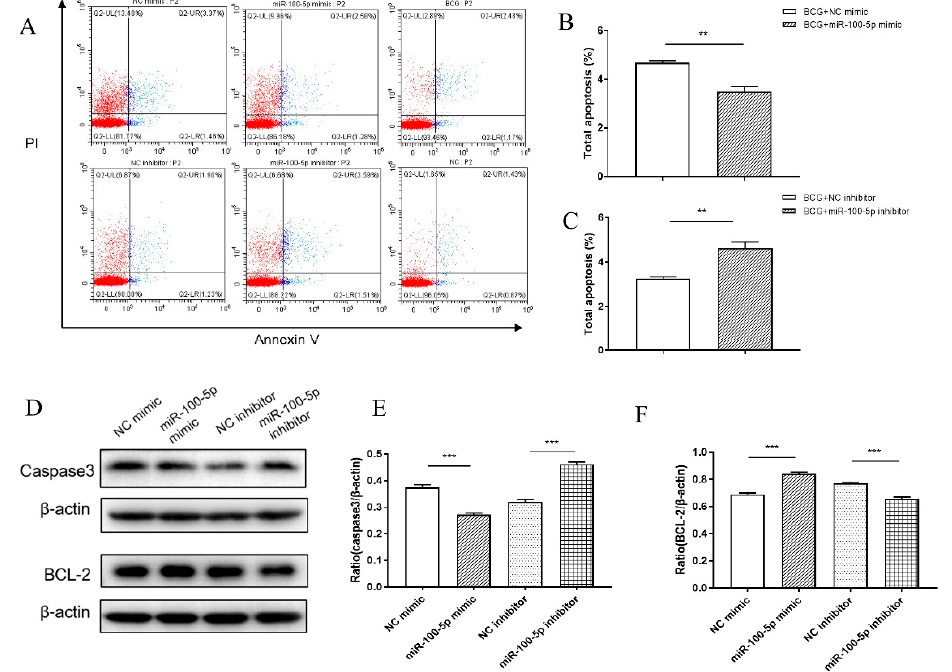
Figure 3. Regulation of apoptosis of BCG-infected THP-1 cells by miR-100-5p. THP-1 cells were transfected with NC mimic, mimic, NC inhibitor, or miR-100-5p inhibitor and then infected with BCG (MOI = 10) for 8 h. ( A ) Cell apoptosis was detected by flow cytometry at 12 hpi. There were six groups: transfected NC mimic and infected BCG, transfected miR-100-5p mimic and infected BCG, transfected NC inhibitor and infected BCG, transfected miR-100-5p inhibitor and infected BCG, untransfected but infected BCG (BCG), and untransfected and uninfected (NC). ( B , C ) Cell total apoptosis rate with different groups. ( D ) Total proteins were collected at 12 hpi. Caspase-3 and Bcl-2 protein levels were detected by Western blotting assay. ( E , F ) Relative protein expression ratios were analyzed using ImageJ with normalization to β -actin. Data are from three independent experiments with biological duplicates in each (( A – C ); mean ± s.e.m. of n = 3 duplicates) or representative of three independent experiments ( D – F ). ** p < 0.01; *** p < 0.001 (Student’s t -test for one comparison